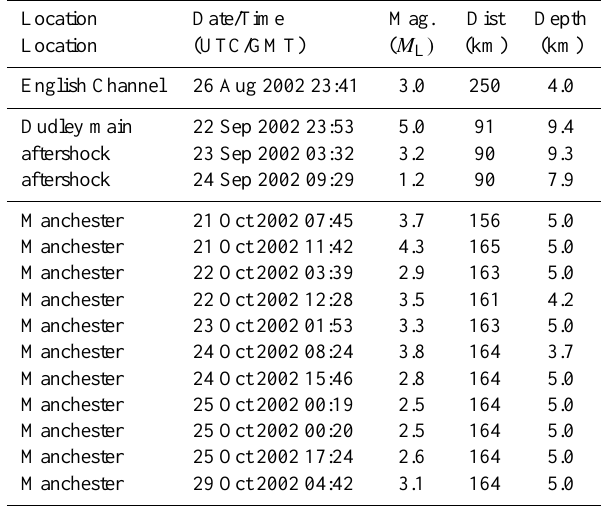
Table 1. Earthquake Data, July–October 2002, (BGS,